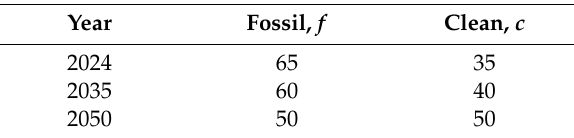
Table 2. Objectives and goals to electricity generation by source energy defined in the General Climate Change Law (GCCL) Prepared by the authors based on public data from cited Reference